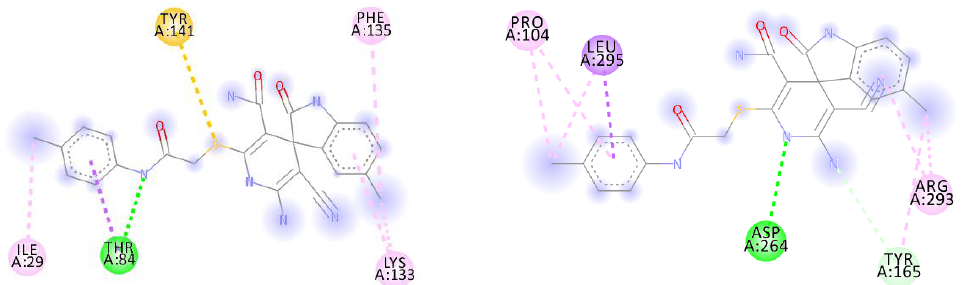
Figure 2. Two-dimensional docking pose interaction diagram with the key amino acids in bacterial protein PqsR binding site for ( R )- 17a ( left ) and ( S )- 17a ( right ) (conventional hydrogen bonds showed green, Pi-Sigma interactions showed purple, Pi-Sulfur interaction showed yellow and alkyl and Pi-alkyl interactions showed pink).